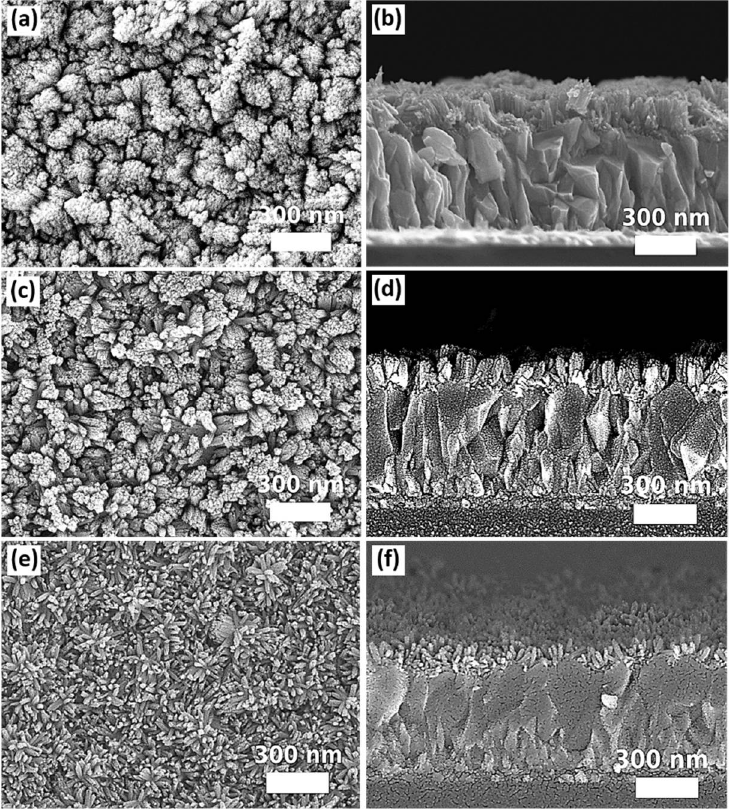
Figure 6. The top-view and cross-sectional SEM images of SnO 2 nanostructures prepared from the precursor solution containing ( a , b ) 6 mL, ( c , d ) 6.5 mL, and ( e , f ) 9.75 mL of acetic acid.